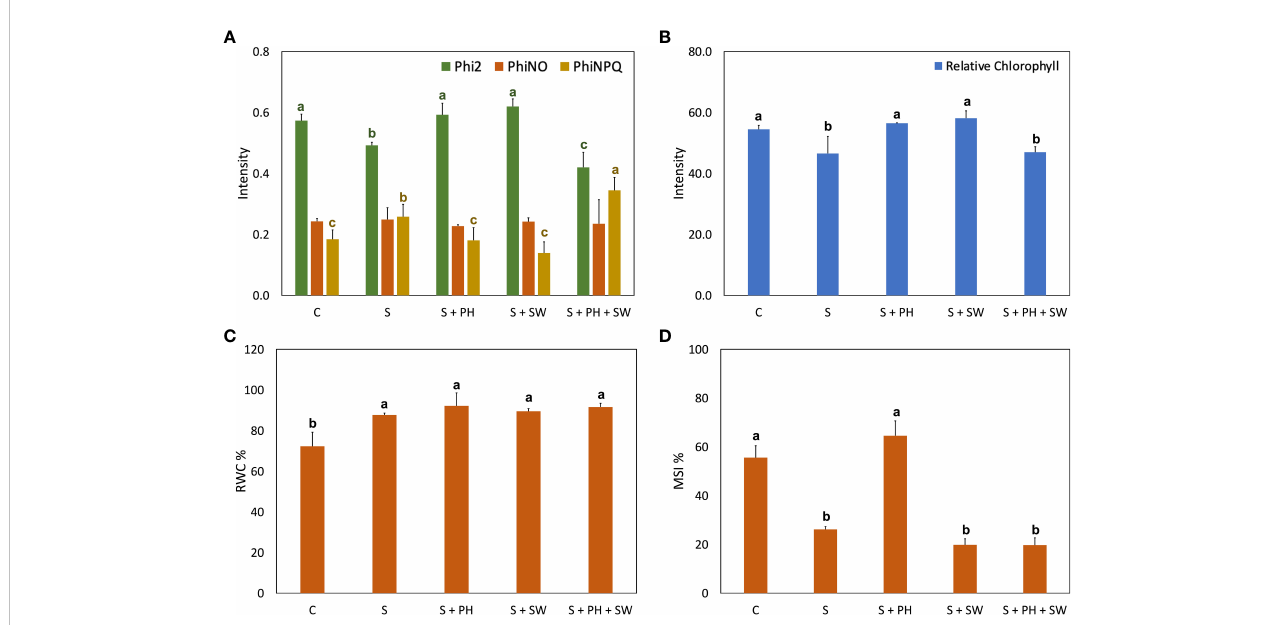
FIGURE 2 Physiological analysis of tomato leaves affected by salinity stress (S) and treated with biostimulants i.e., protein hydrolysate (PH), seaweed extracts (SW), and their combination PH + SW, compared to the control non-stressed plants (C) . In the panel shows (A) photosynthetic performance expressed as quantum yield of the photosystem II (Phi2), ratio of incoming light that is lost via non-regulated processes (PhiNO) and non-photochemical quenching (PhiNPQ). In (B) relative chlorophyll content. In (C) % of relative water content (RWC) in tomato leaves. In (D) % of membrane stability index. Error bars indicate standard errors ( n = 3). Different letters indicate signi fi cant differences according to Tukey ’ s multiple-range test ( p =